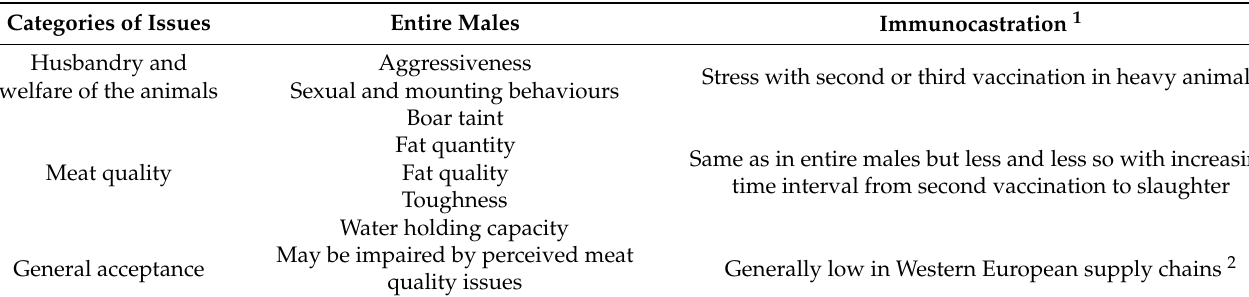
Table 1. Main issues associated with entire males and immunocastration [4–9].